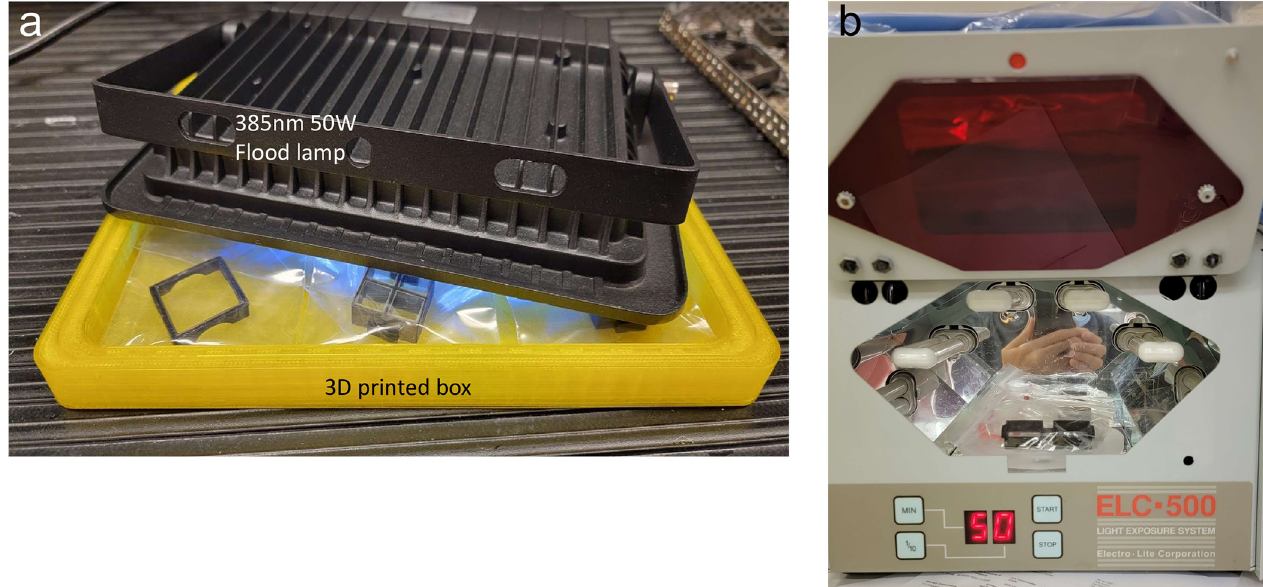
Fig 3. Thermochromic chamber holder for live cell incubator stage. (a) Left to right: the lid, chamber, and holder. (b) Assembly of the chamber and holder in the stage at 25˚C with grey color. (c) Placement of the chamber and holder within the incubated temperature and gas control chamber at 37˚C with color change to orange. (d) As in panel c, but temperature increased to 42˚C